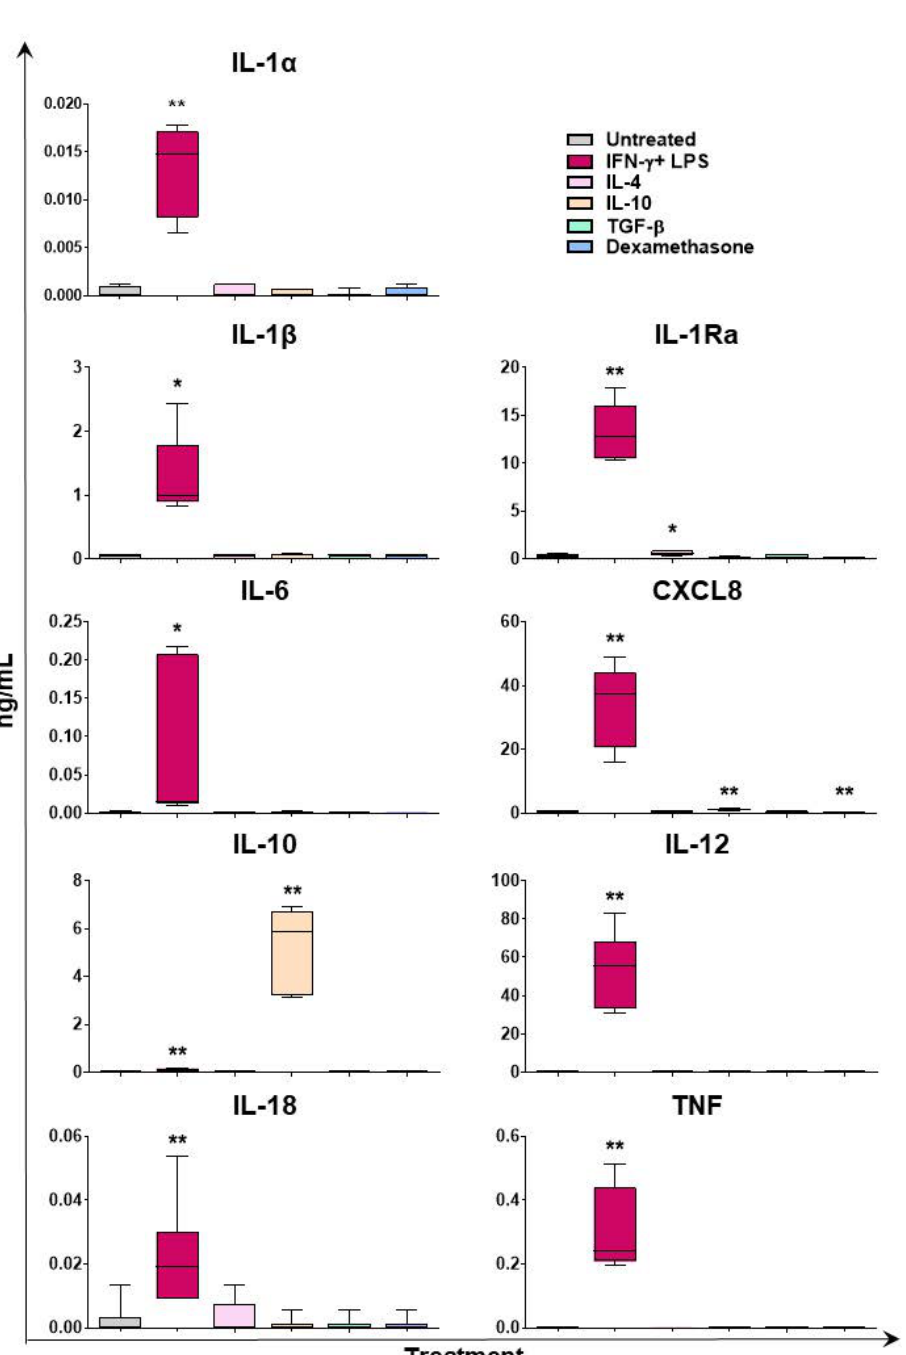
Figure 6. Cytokine content in culture supernatant of moM Φ stimulated with diverse polarizing factors. Porcine moM Φ were left untreated, or they were stimulated with diverse polarizing factors: IFN- γ + LPS (both at 100 ng/mL), IL-4 (20 ng/mL), IL-10 (20 ng/mL), TGF- β (20 ng/mL), or dexamethasone (20 ng/mL). Then, 24 h post-stimulation, levels of IL-1 α , IL-1 β , IL-1Ra, IL-6, CXCL8, IL-10, IL-12, IL-18, and TNF were determined using a multiplex ELISA. Data from three independent experiments utilizing different blood donors are presented. Data are displayed as box-and-whisker plots, showing the median and interquartile range (boxes) and minimum and maximum values (whiskers). Values of treated macrophages were compared to the untreated control (moM Φ ) using a Mann–Whitney test. ** p < 0.01, and * p <